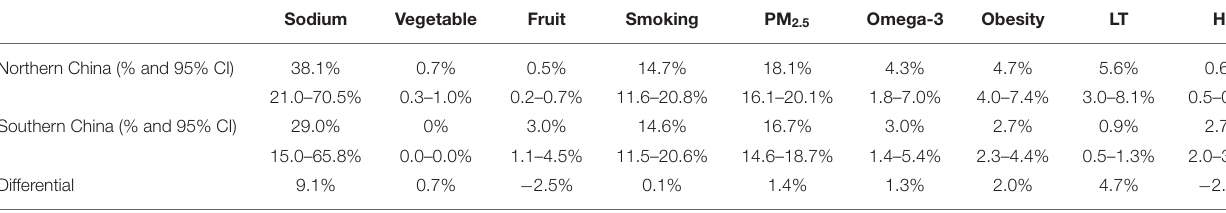
TABLE 3 | Attributable fraction of risk factors for heart disease in northern and southern China.